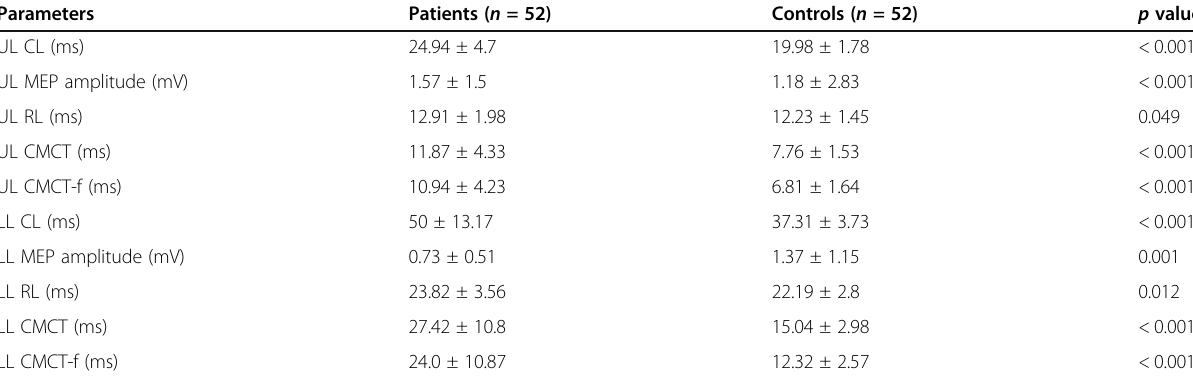
Table 3 TMS parameters of patents with multiple sclerosis and control subjects Parameters